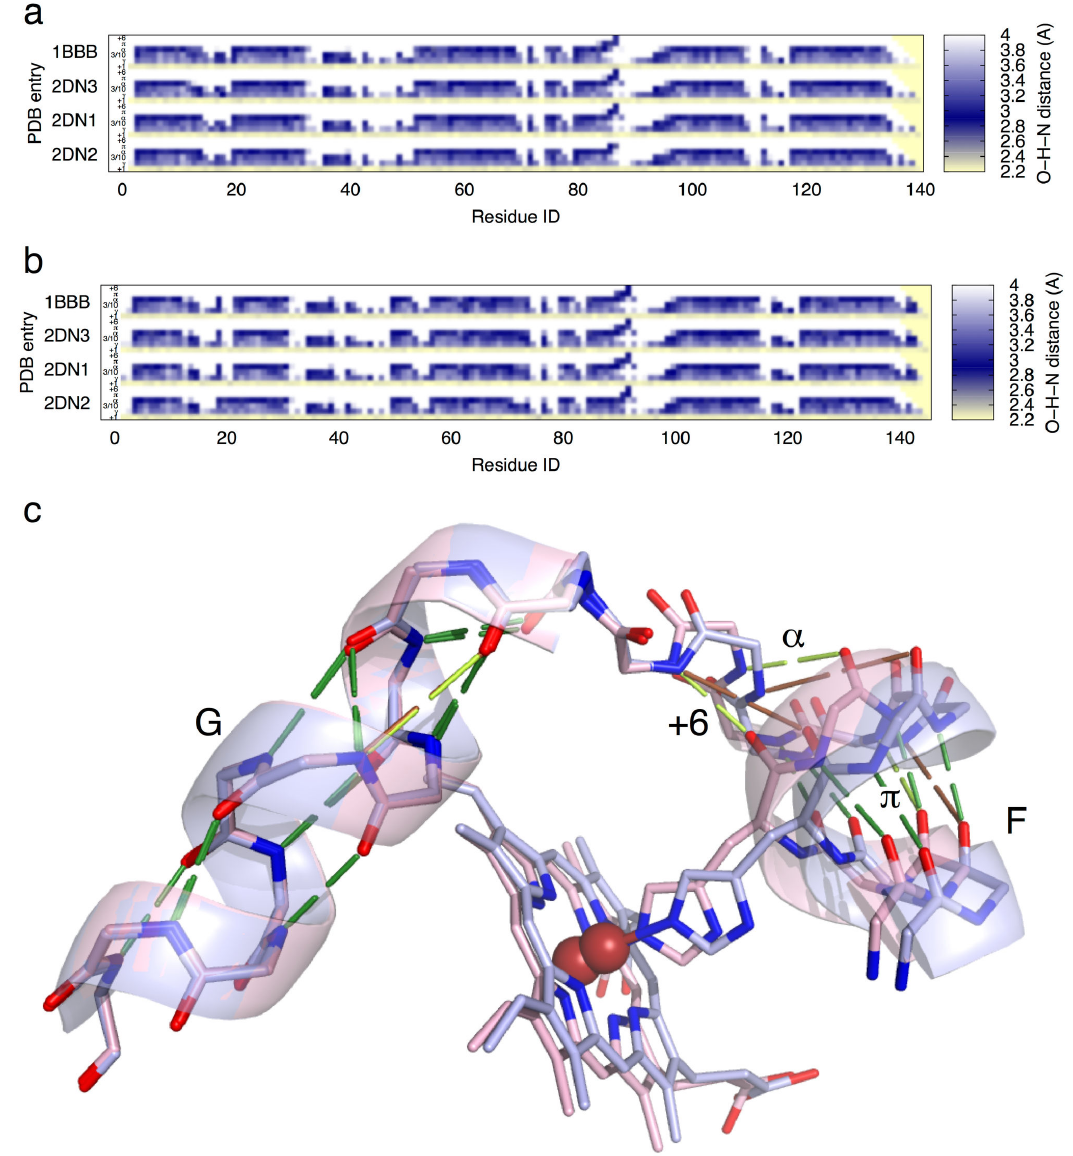
Figure 5. Main chain H-bonds. Upon ligand binding, the main chain around heme anchor gains a total of four H-bonds. However, these additions do not occur simultaneously, and they take place differently in α and β. a. HIM of α. b. HIM of β. An HIM is a specialized distance matrix that contains only helix-forming H-bond lengths in a main chain, and has only several rows as labeled +1, γ, 3/10, α, π, and +6. The i -th column contains distances from a main chain carbonyl O of residue i to the amide Ns of residues i + 1 to i + 6. A distance value in a row within the proper range for H-bonding is colored in dark blue to show strong H-bond and to indicate a specific type of helix or turn. Large distances fade to white and short distances turns into yellow. PDB entries are labeled on the left. c. Main chain consensus around heme anchor in all states and subunits. T state structure is in light blue. A ligated state in R or R2 is in pink. The C-terminus of F that anchors the heme group is shown on the right. All side chains except the proximal His are removed. The constant H-bonds in all states are presented by dark green rods. The newly formed H-bonds in ligated states are in light green. These H-bonds not yet formed in T state are in brown. The strong H-bond gained at proximal His87αO-Val93αN is marked +6. The equivalent H-bond in β proximal His92βO-Val98βN already exists in T state. A weaker H-bond Ala88αO-Arg92αN continues the α conformation as labeled α. In R2 state, an additional strong H-bond Asp85αO-Lys90αN extends the π helix further upstream. In β, the equivalent new H-bond Glu90βO-Lys95βN is the only addition that extends the π helix upstream in both R and R2 states as labeled π. A weaker addition of H-bond in G on the left is Pro95αO-Lys99αN, which puts the beginning of Gα in a transition between 3/10 and α conformation. This transitional conformation is constant in β. doi: 10.1371/journal.pone.0077141.g005 PLOS ONE |